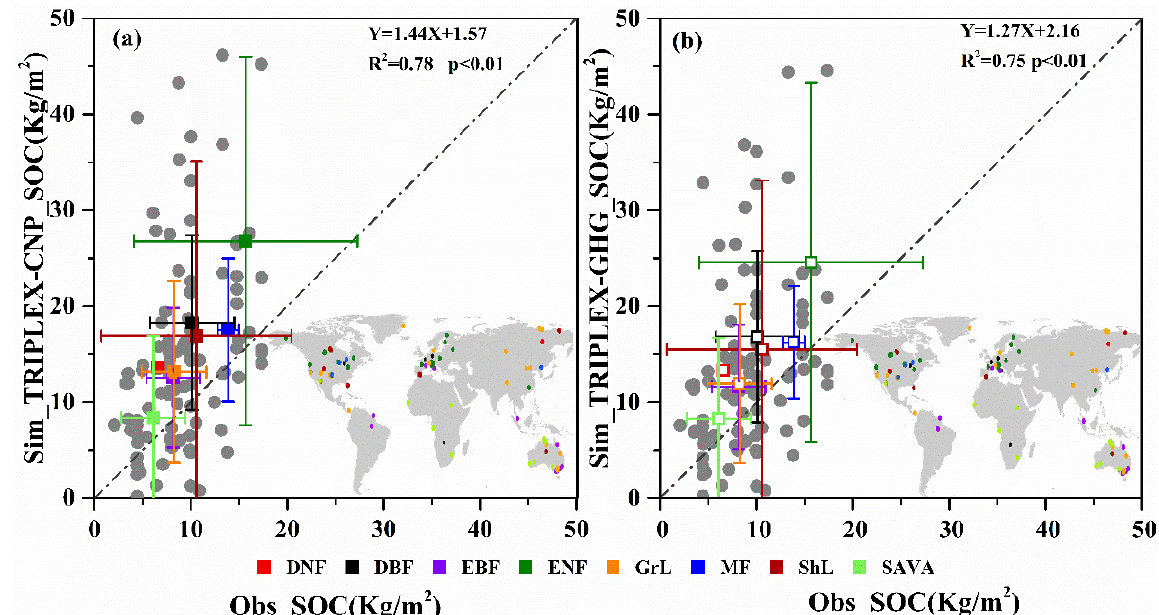
Figure 5. Comparison of SOC simulated by ( a ) TRIPLEX-CNP or ( b ) TRPLEX-GHG and observed SOC from the HWSD. The gray points show data from the same 116 sites used for GPP validation (Figure 3). Squares are colored according to biome, as defined in the legend to Figure 3.